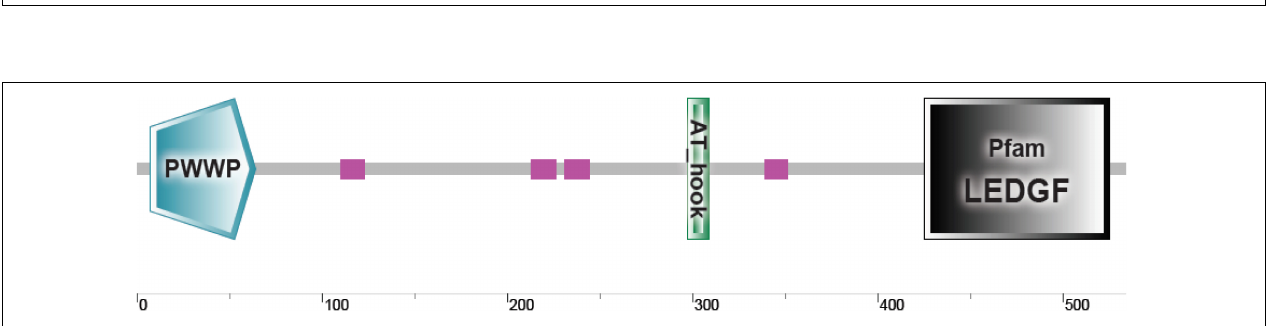
FIGURE 9 | MrLEDGF sequence domain organization. Schematic representation of newly discovered MrLEDGF and its domain organization as predicted by SMART.